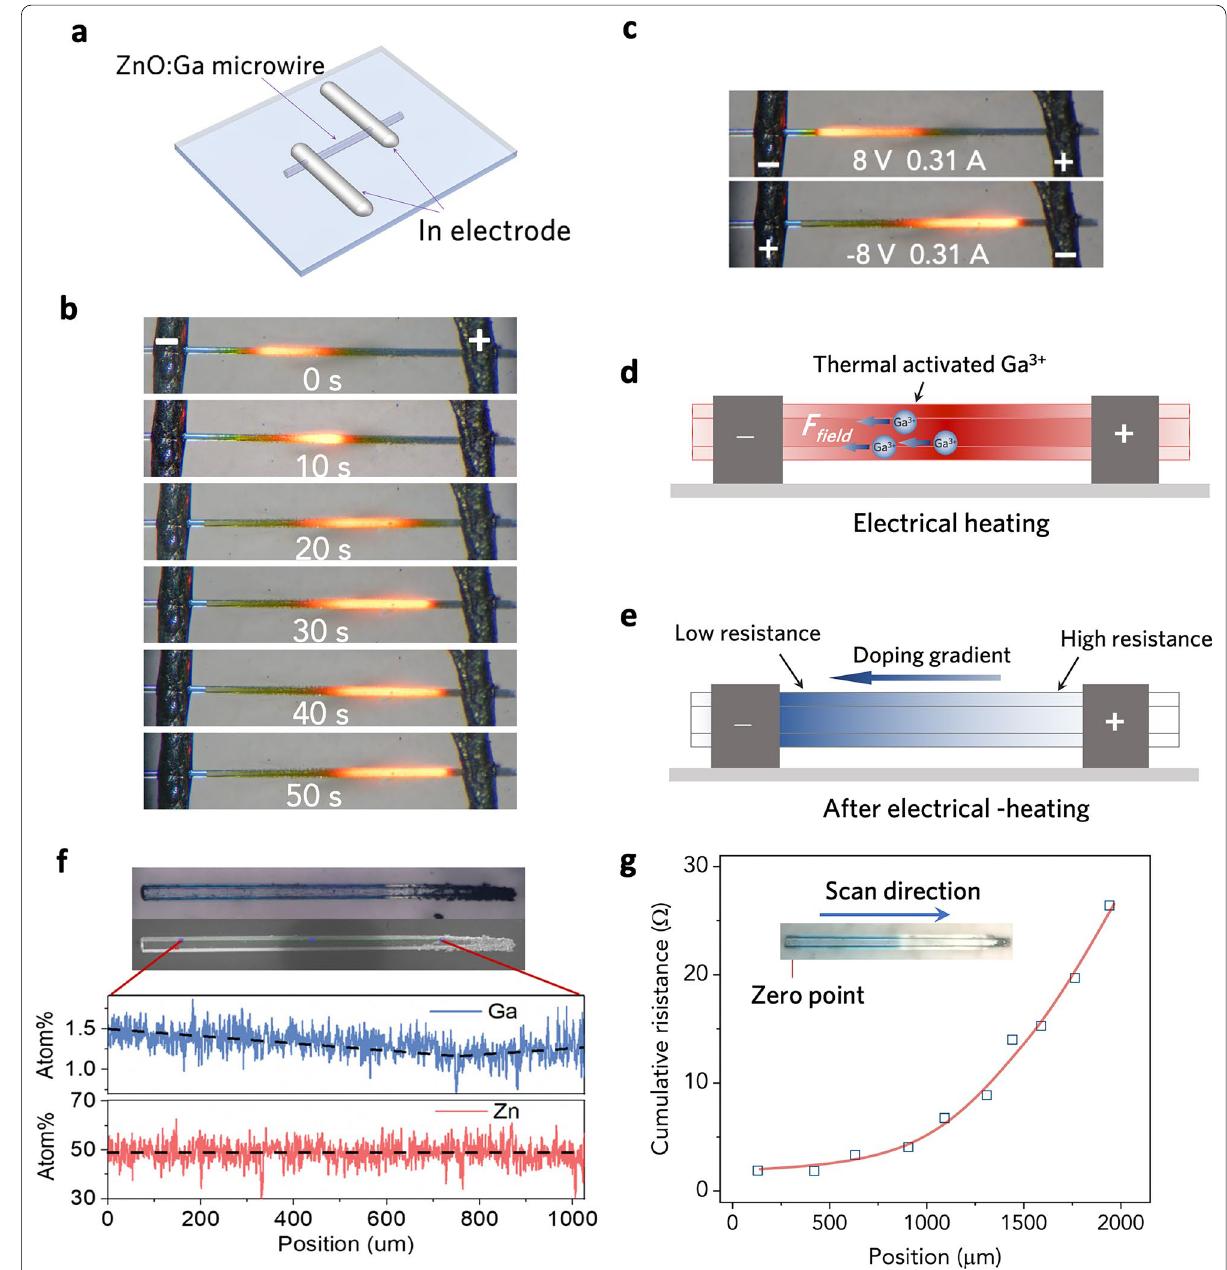
Fig. 2 a Schematic of the Ga-doped microwire heating device. b The optical image of hotspot transport when the high voltage was applied. c The hotspot position under forward and reverse bias. d Schematic diagram of the impurity migration in the Joule heated microwire. e The regulated resistance along the microwire after impurity migration. f The optical/SEM image of the microwire after dopants redistribution and the EDS line scan spectrum along the microwire. g Line-scan of the resistance along the